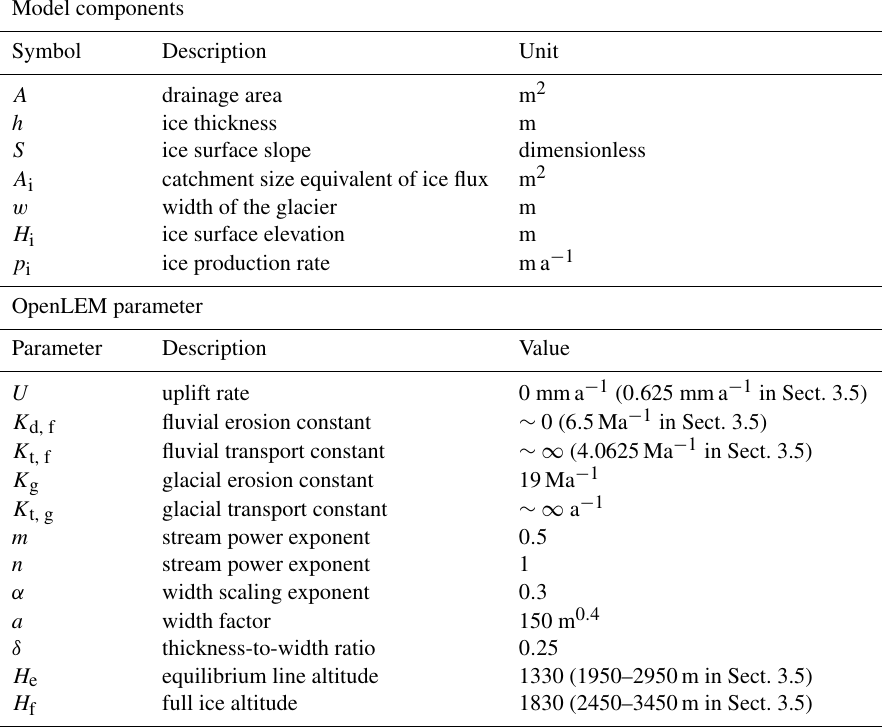
Table A1. Stream power law of glacial